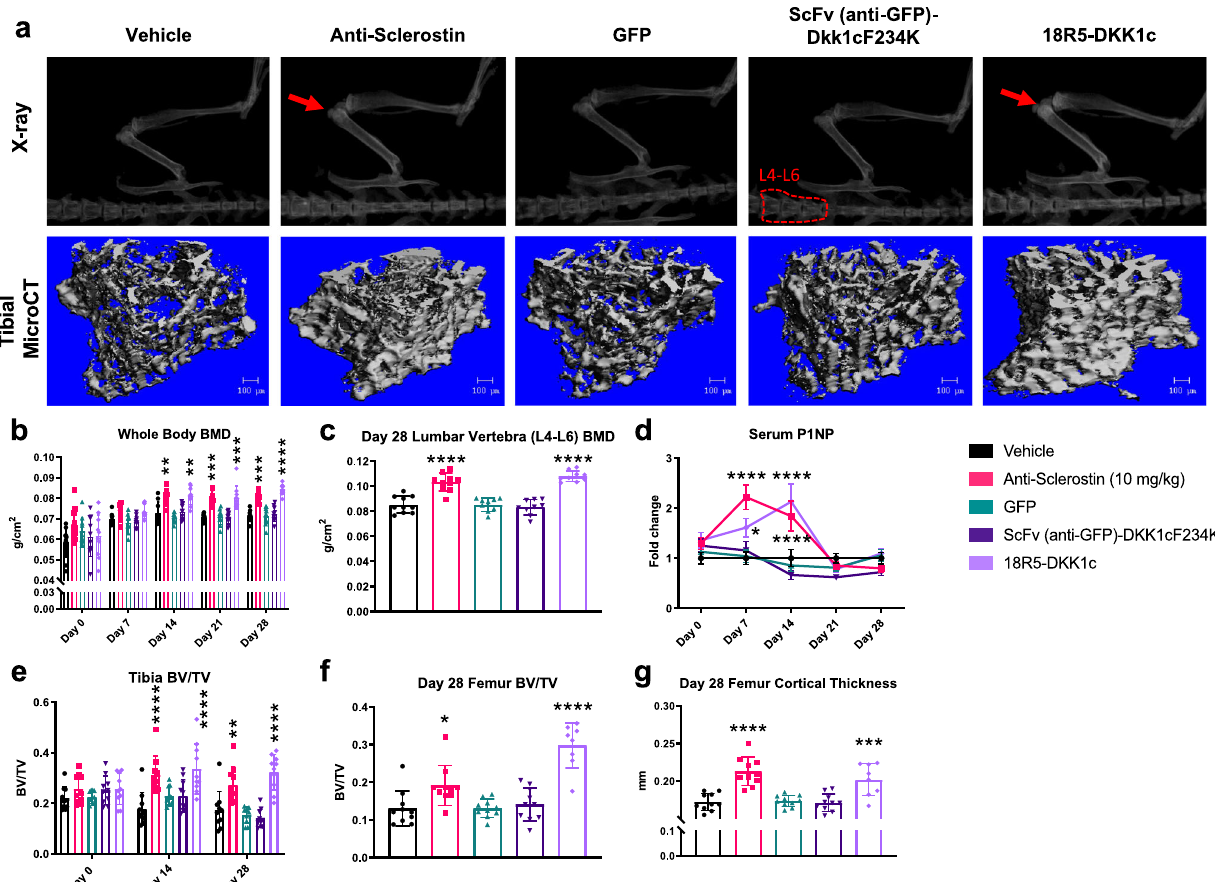
Fig. 2 Radiographic and serum analyses of bone accrual induced by Wnt mimetics. a Representative x-ray (top row) and micro-computed tomography (micro-CT) (bottom row) images at day 28. For x-ray, individual sample regions of interest (ROI) quanti fi ed the longitudinal ( b ) average whole-body bone mineral density (BMD). a Red arrows point to increased bone mineral (radiographic contrast) in the distal femur and proximal tibia. Red dotted regions demarcate the ROI analyzed for c average lumbar vertebra (L4 – L6). d Serum samples obtained at days 0, 7, 14, 21, and 28 were assessed for procollagen type-1 N-terminal propeptide (P1NP). For each time point, the serum P1NP levels for all test groups are normalized to the average of vehicle-treated P1NP serum concentration. e Longitudinal average tibial BV/TV at days 0, 14, and 28. f Day 28 ex vivo endpoint micro-CT quanti fi cation of the distal femoral